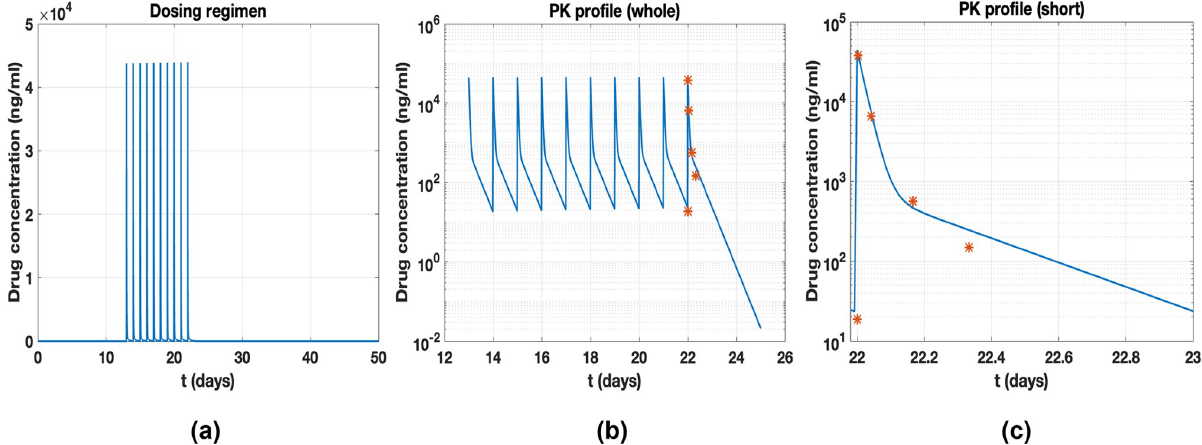
Fig 2. (a) Dose regimen per day from day 13–22. (b) Simulated PK profiles are plotted. The red symbols indicate observed PK data after the final injection. (c) Simulated PK profile shown in the study [4] is reproduced.